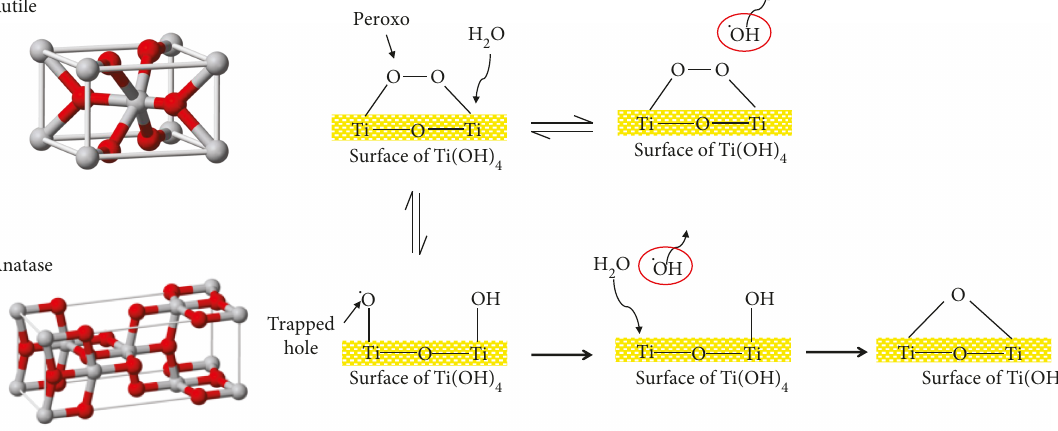
Figure 9: Schematic illustration of OH generation at rutile and anatase TiO